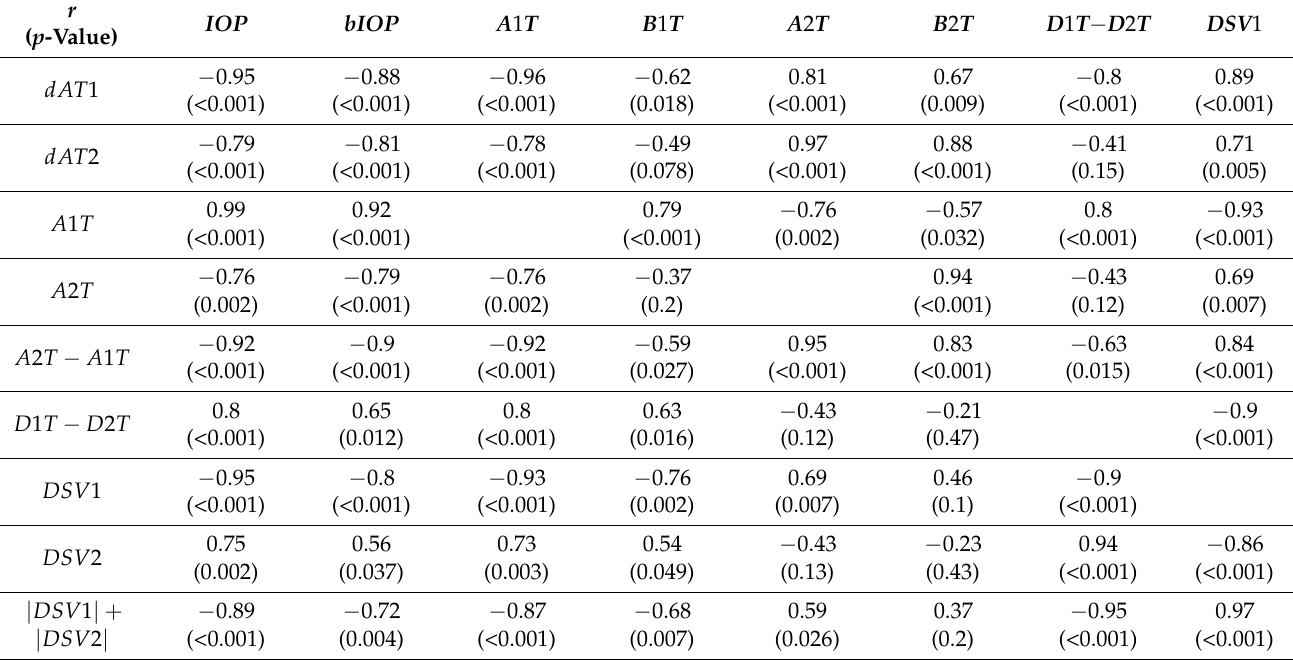
Table 2. Pearson’s correlation coefficients r with p -values (in parentheses) between selected param- eters related mainly to both applanation times, D 1 T and D 2 T times, and extremal profile slope velocities, DSV 1 and DSV 2. The parameters in the table were selected to have high correlation with IOP .